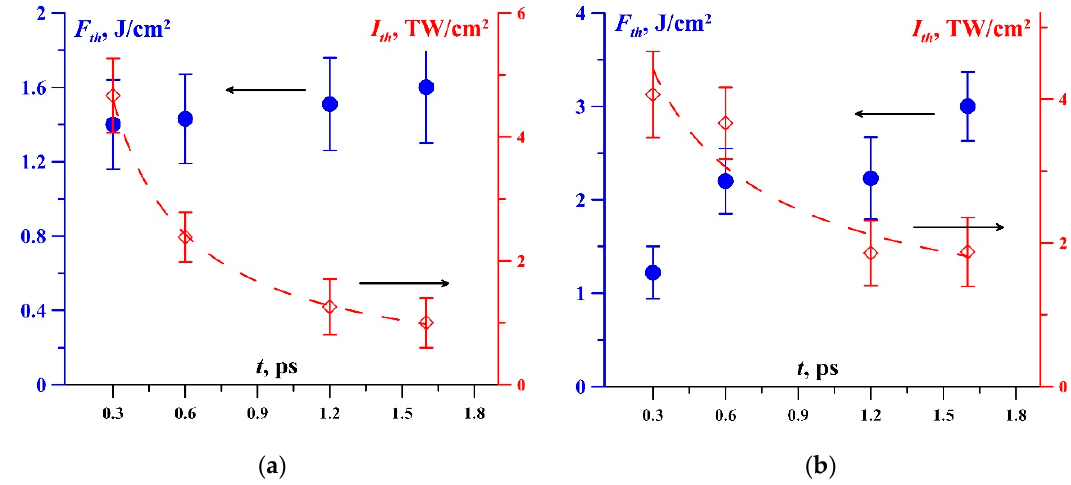
Figure 4. Dependence of optical damage threshold (fluence and intensity) of BWO crystal on the laser pulse duration at 1030 nm wavelength for ( a ) “colored” and ( b ) “clear” BWO crystal. Table 2. Optical damage threshold of BWO surface at different experimental conditions.